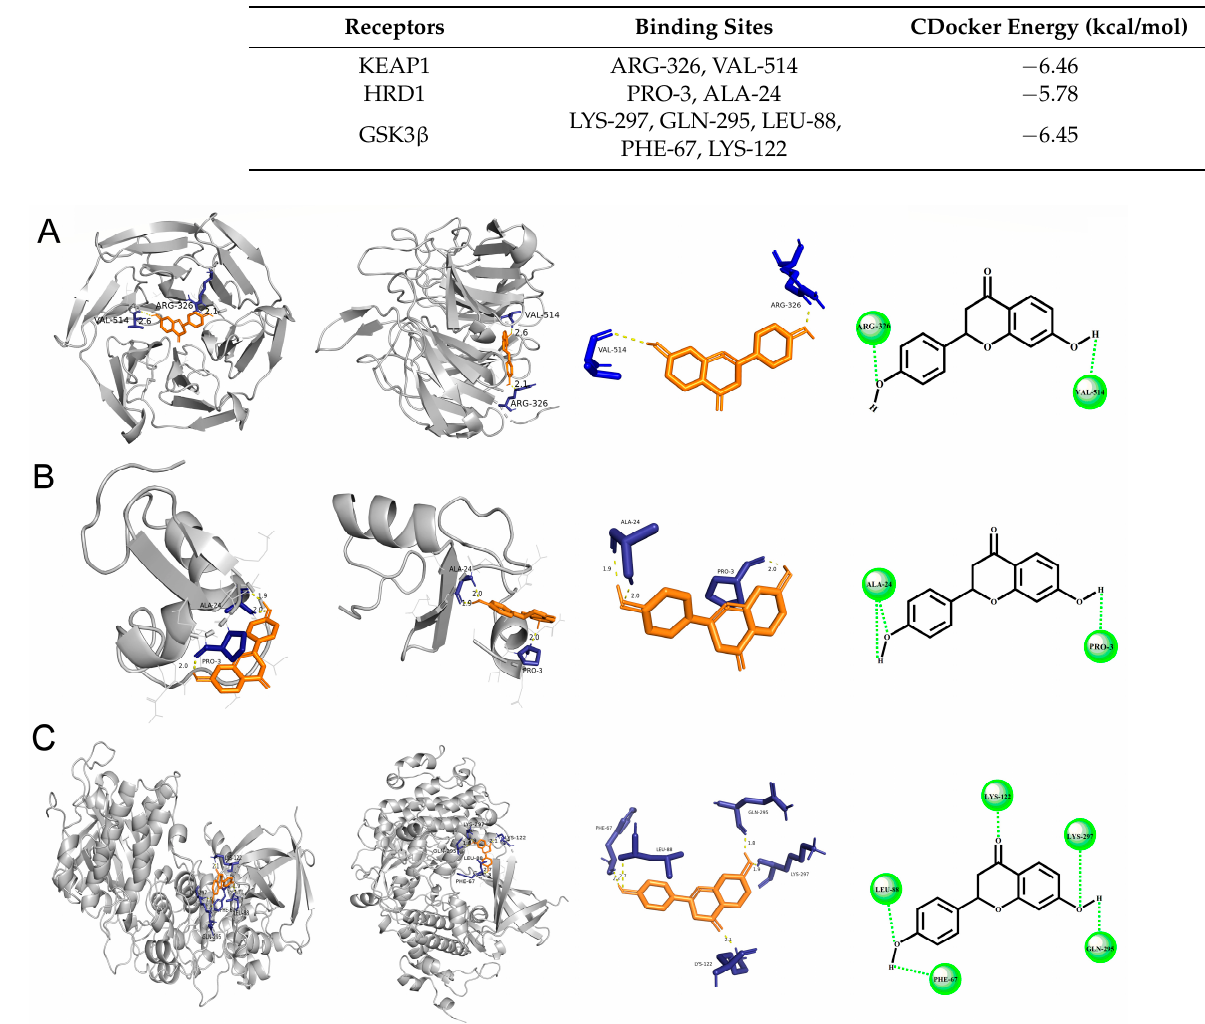
Table 1. Docking energies for optimal conformation of liquiritigenin to KEAP1, GSK-3 β and HRD1.